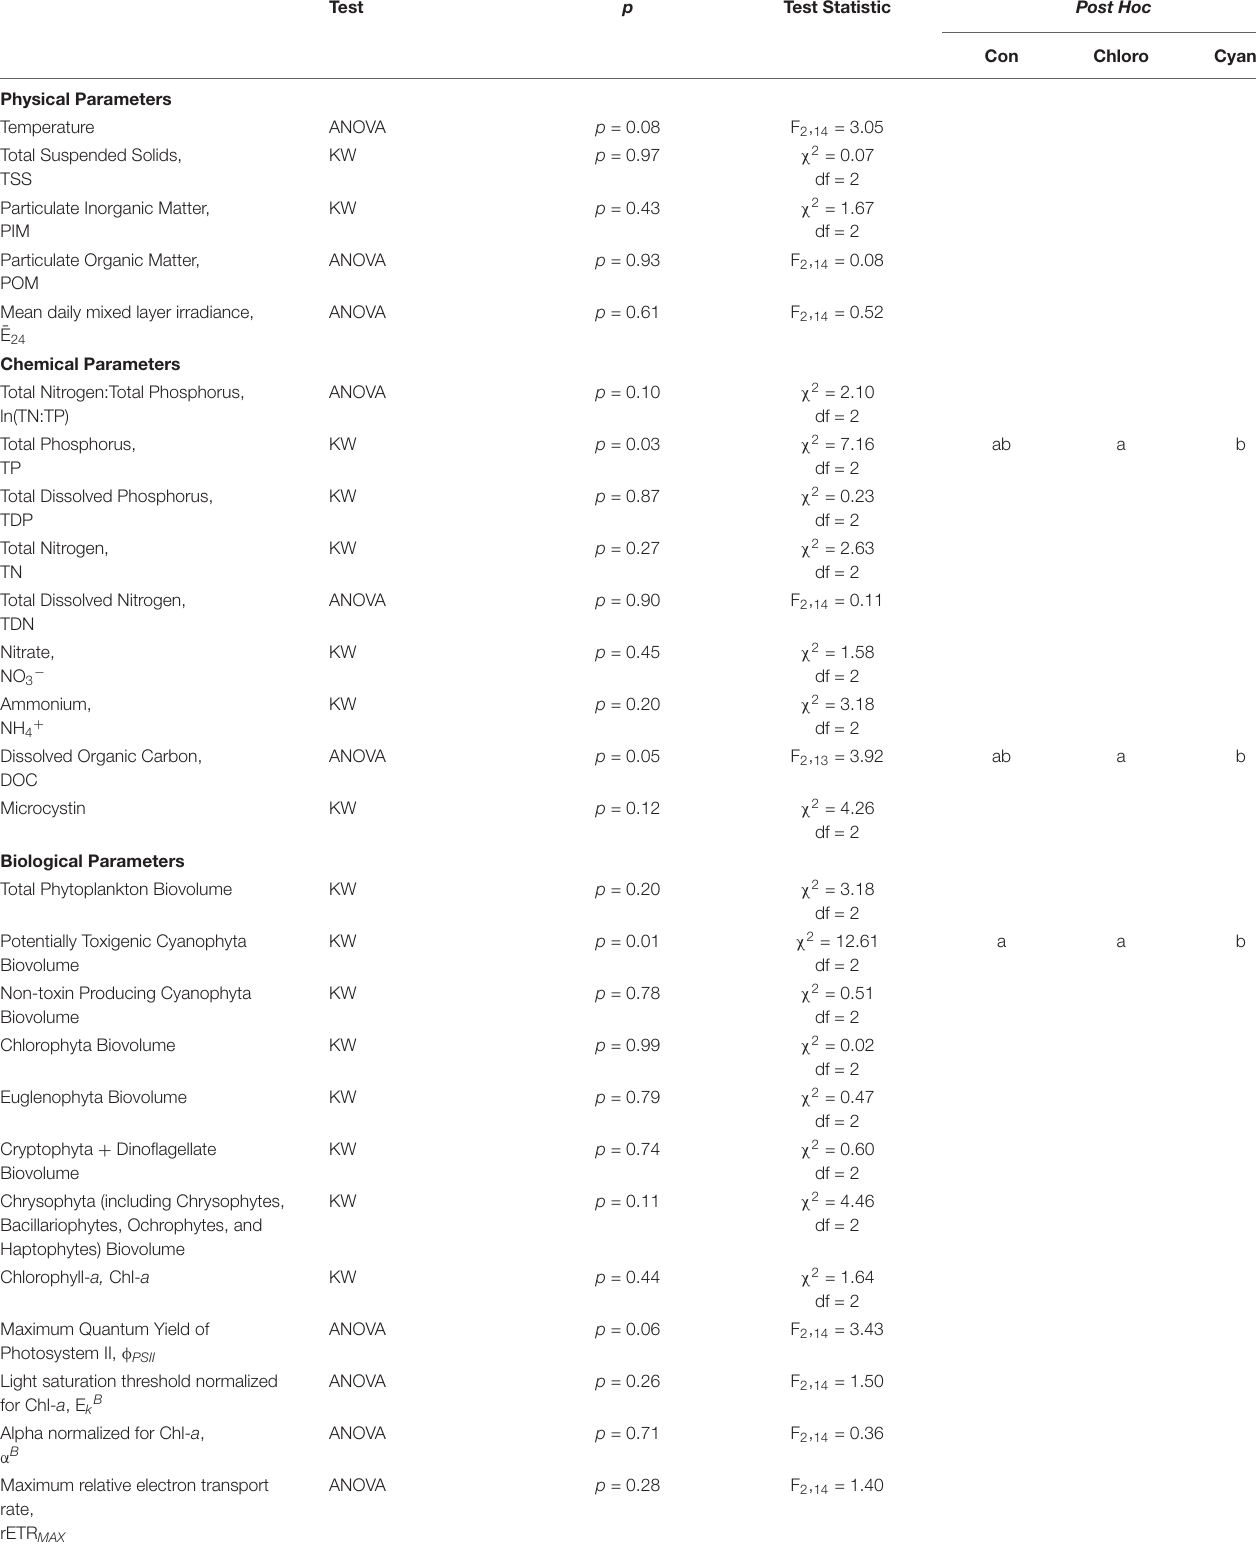
TABLE 4 | Statistical analyses for each parameter. Test p Test Statistic Post Hoc